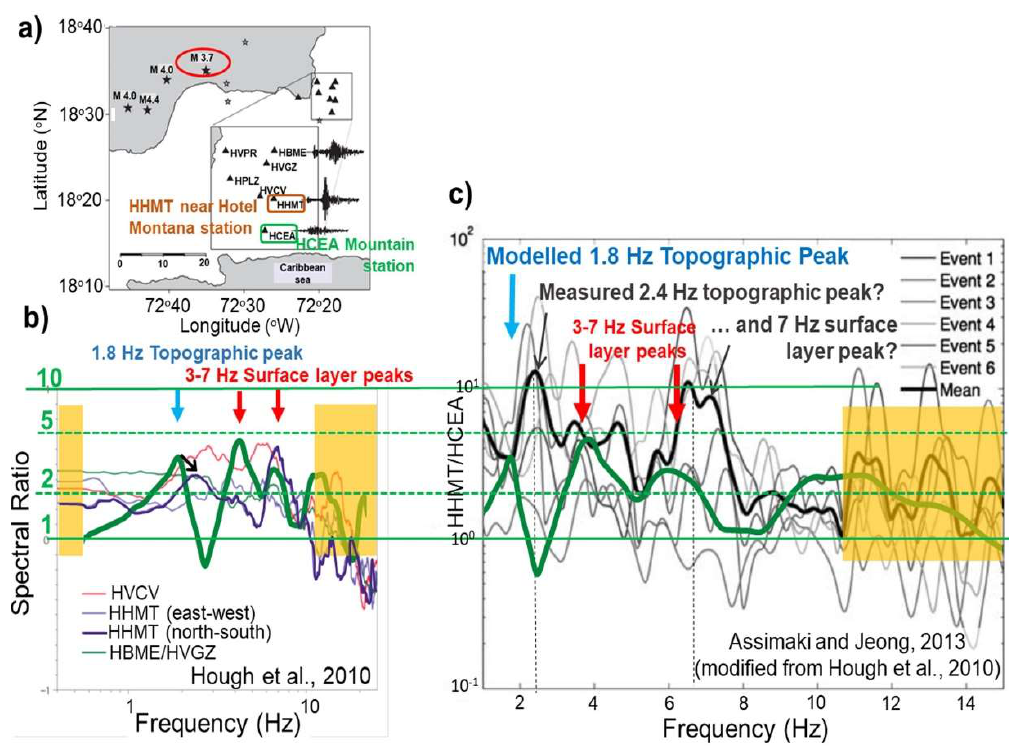
Figure 10. ( a ) Map of stations and recorded aftershocks (from [6]) with highlighted Hotel Montana and HCEA bedrock station (on hard limestone) in the mountain massif to the south of Gros-Morne hill. ( b ) Simulated surface layer model SSR for the equivalent HM site computed with respect to S9 receiver (representing the Delmas 60 site, see bolt green curve) compared with the spectral ratios for several sites inside and near Port-au-Prince, presented by [5], on the basis of recorded aftershocks of the 12 January 2010, event (the N–S spectral ratio for Hotel Montana, HHMT, computed with respect to mountain station HCEA, is shown by the highlighted violet curve); the same modelled SSR (bolt green curve, with changed amplitude and frequency scale) is compared in ( c ), with the spectral ratios obtained for the 2010 aftershock dataset analyzed by [6] for Hotel Montana. Several amplification levels are marked by green lines. See also parts of spectrum with low energy content in the modelled input signal marked by an orange semi-transparent mask.